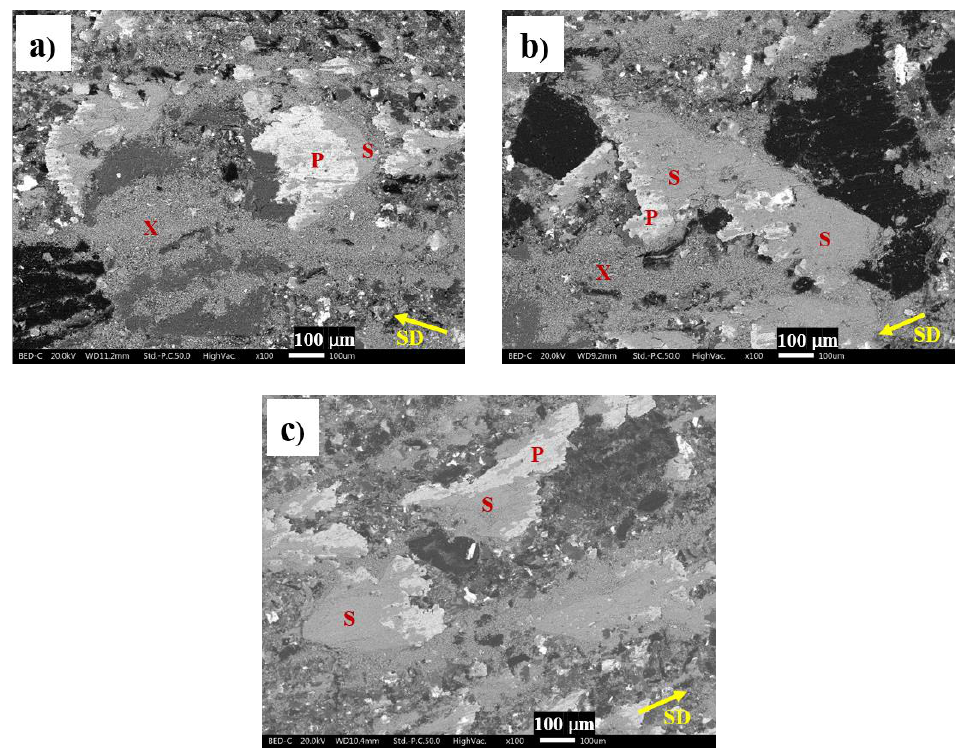
Figure 7. SEM micrographs showing the surfaces of the pins after the PoD tests at RT: ( a ) M0, ( b ) M0_G and ( c ) M0_CN. P — primary plateaus; S — secondary plateaus; X — non-compacted wear particles; SD — sliding direction.